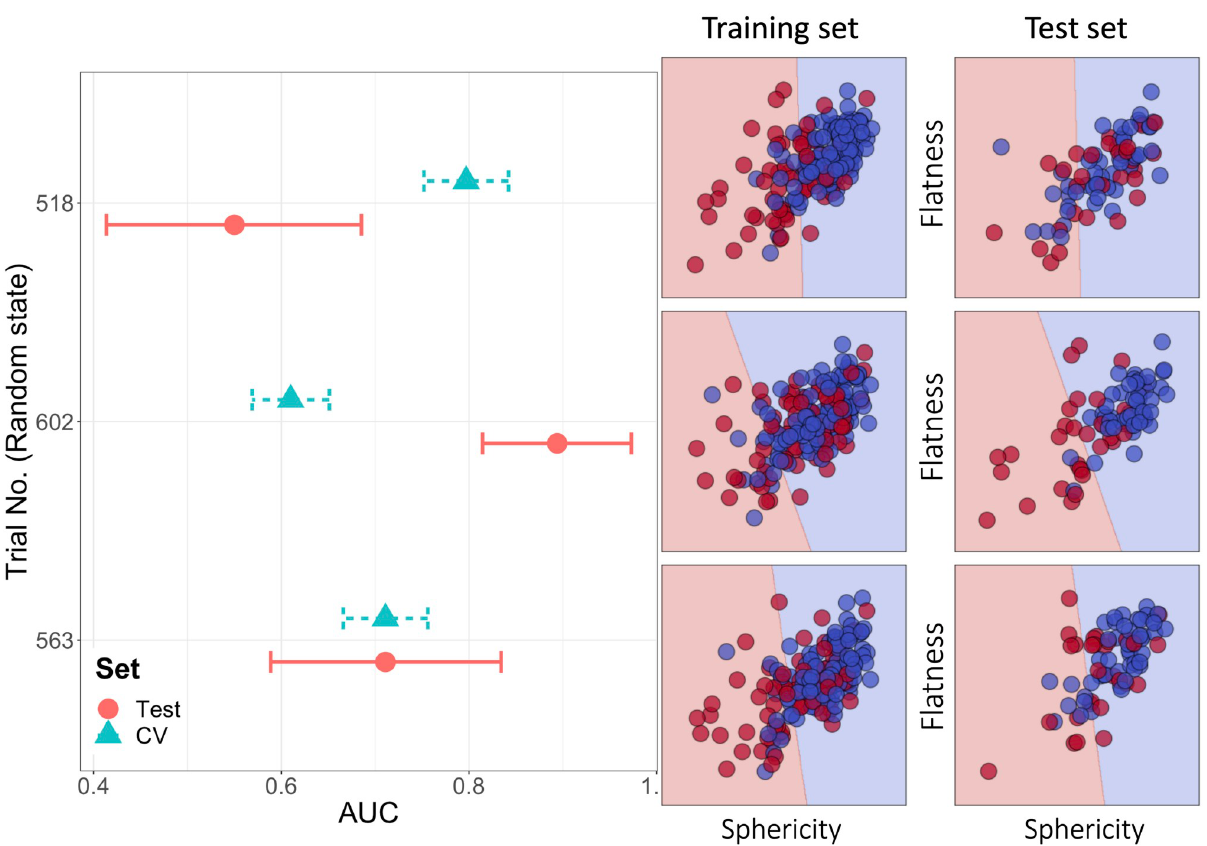
Fig 4. Discrepancy between performance estimated from cross validation in the training set and performance in the test set (i.e., generalization gap), explained by the distribution of datapoints in the feature space. The left panel shows that mean cross-validated AUC in the training set and AUC in the test set in three representative trials. The horizontal error bars are standard deviation for CV and 95% confidence interval for testing. The right panel shows the distribution of datapoints in the space consisting of two most important radiomics features (sphericity and flatness). The blue and red dots indicate low- and high-grade meningioma cases, respectively. The linear line dividing the feature space into two areas is a decision boundary; if a datapoint is located in the blue or red area, the model predicts that it is low- or high-grade meningioma, respectively.